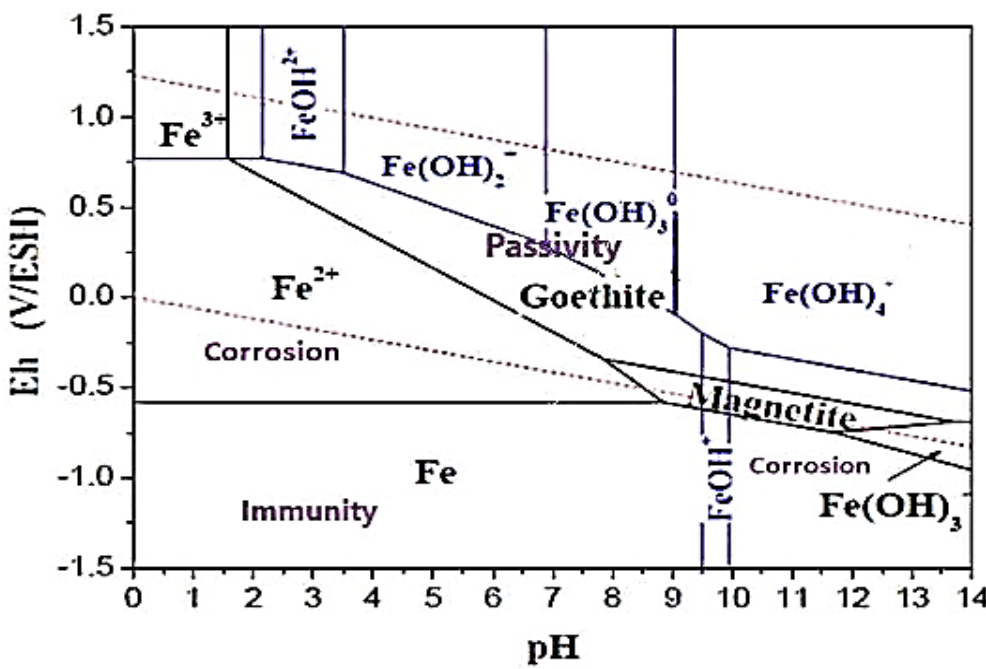
Figure 1. Pourbaix E-pH diagram for iron/water/oxygen systems ([Fe] total = 10 − 5 mol·L −1 , all oxidized phases of iron are considered).